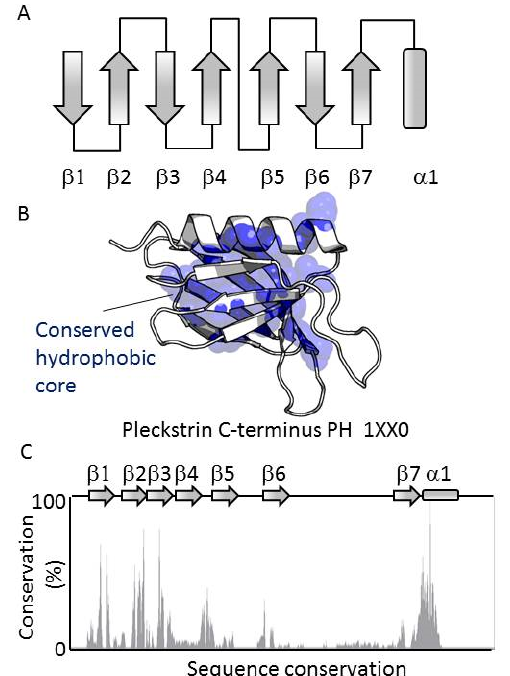
Figure 1. Structure of the PH domain. ( A ) The secondary structure elements of the PH domain fold are shown, including the seven antiparallel β -strands and the C-terminus helix; ( B ) Mapping of residues with at least 50% identity across the PH domain family. The conserved residues are represented by yellow spheres; ( C ) Sequence conservation within the human PH domains. The conservation is expressed in percentage of conservation according to the ClustalX scheme. The reference sequence is that of the C-terminal PH domain of